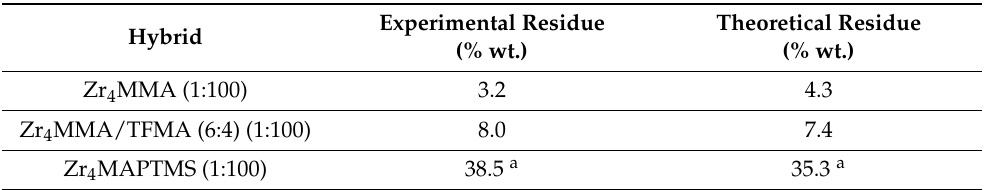
Table 2. Weight residues, based on the molar ratio between the oxocluster and monomers, found by TGA of three synthesised hybrids.